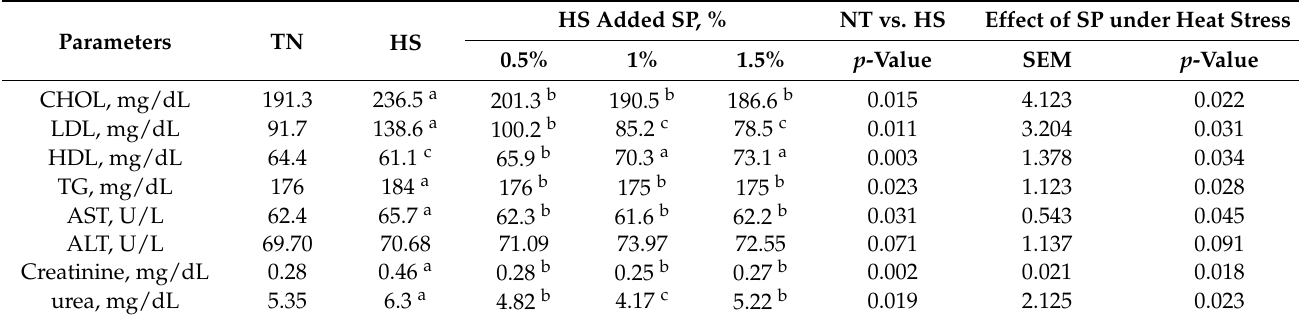
Table 4. Effect of dietary Spirulina platensis supplementation at different levels on blood serum profile of broiler chickens subjected to cyclic heat stress starting from 22 to 42 days of age.